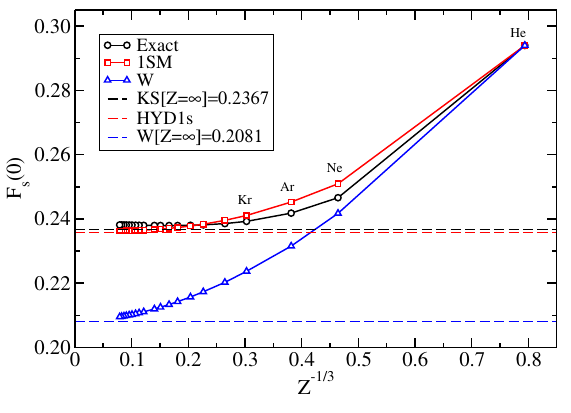
Figure 2. Kinetic energy enhancement factor F s at the nuclear cusp, for the noble atoms (2 ≤ Z ≤ 2022); see the text for